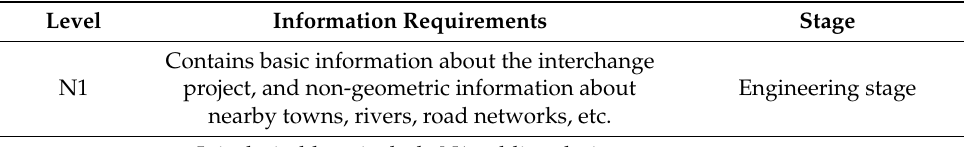
Table 5. Classification of BIM components’ information